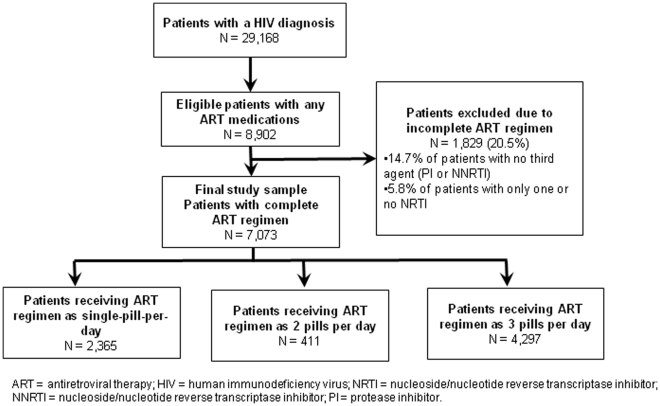
Sample Selection Flow Chart.